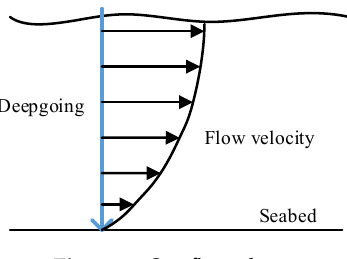
Figure 5. Sea flow shear.